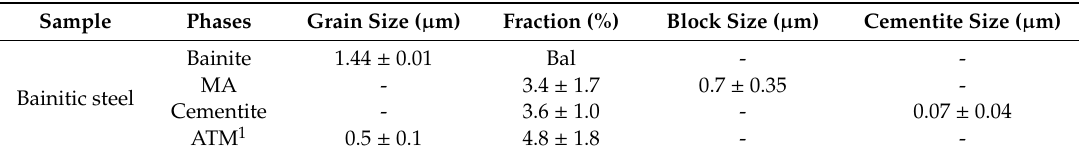
Table 2. Microstructural variables of the bainitic steel.